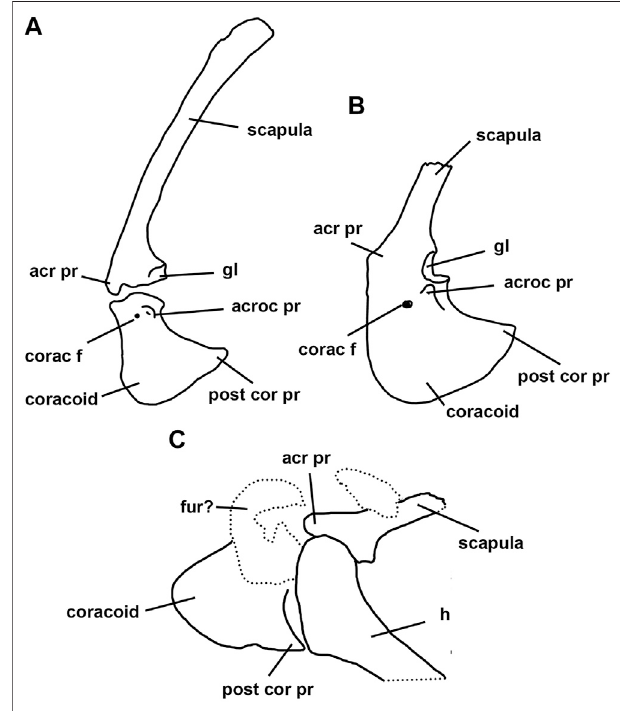
FIGURE 5 | Right scapulocoracoid of selected troodontids in anterodorsal view. (A) , Gobivenator mongoliensis ; (B) , Sinornithoides youngi ; (C) , Jianianhualong tengi [ (A) modi fi ed from Tsuihiji et al., 2014; (B) modi fi ed from Currie and Dong, 2001; (C) modi fi ed from Xu et al., 2017). Abbreviations. acr pr, acromion process; acroc pr, acrocoracoid process; corac f, coracoid foramen; fur? furcula? gl, glenoid; h, humerus; post cor pr, posterior coracoid process. Not to